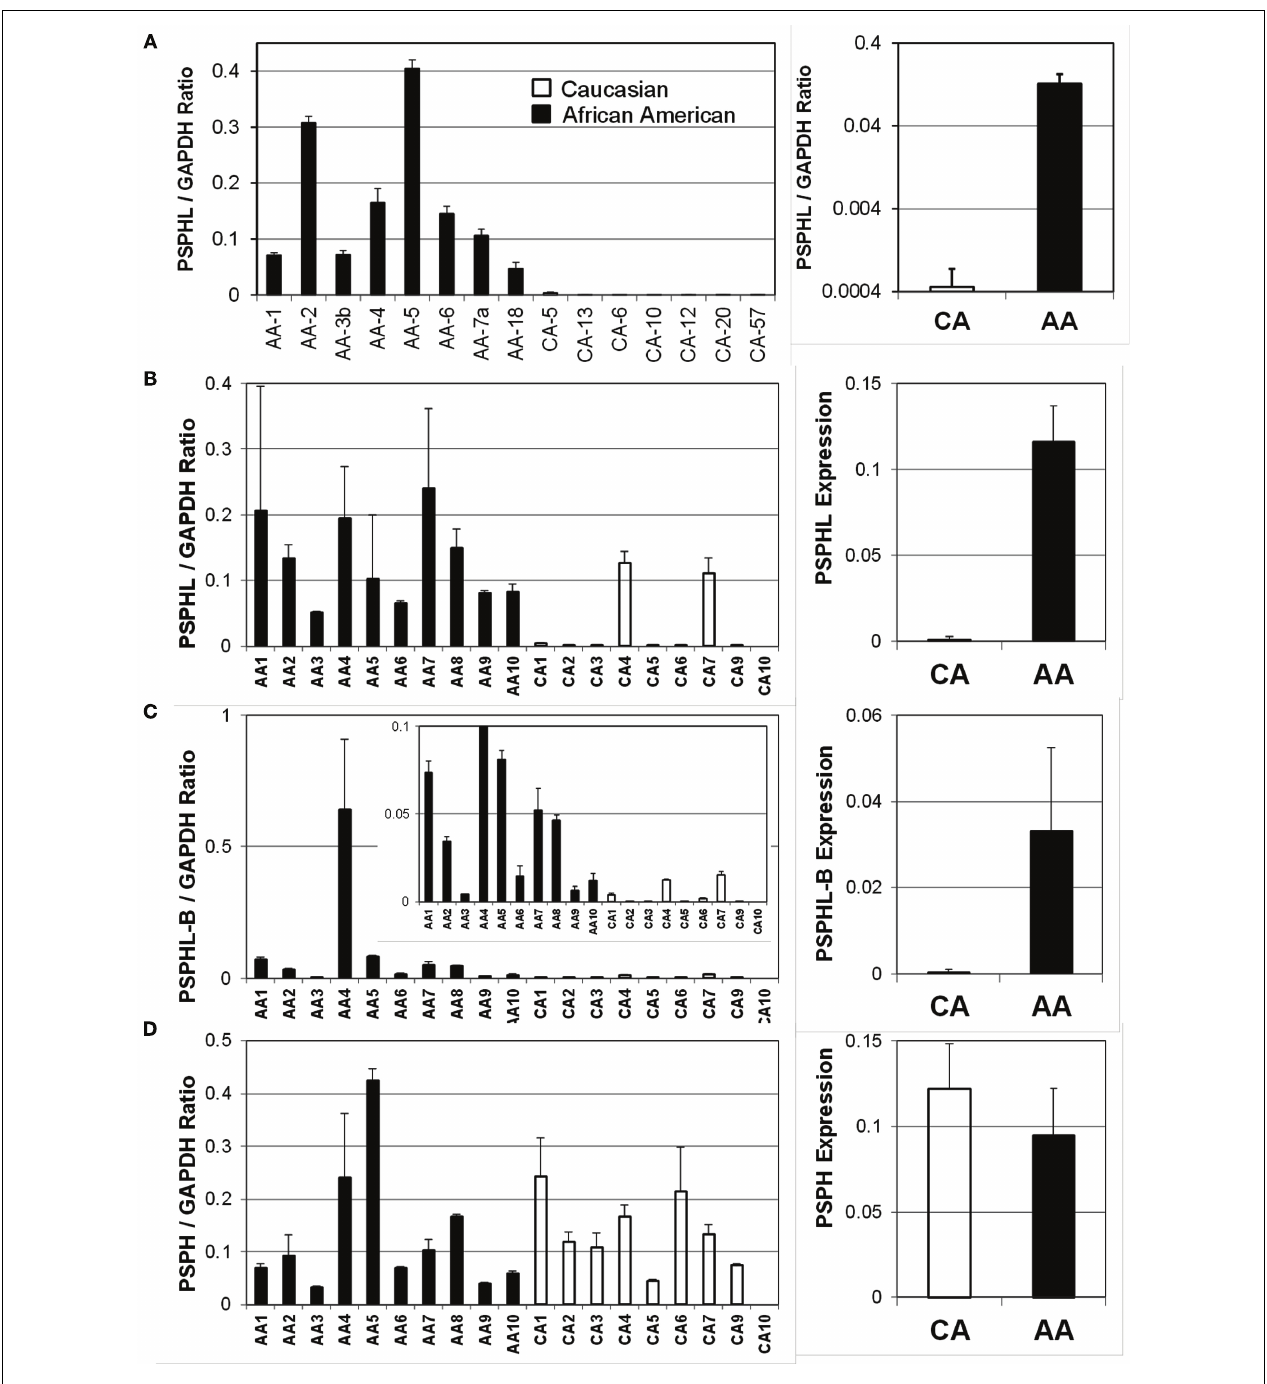
Right: geometric averages. Error bars indicate standard error.The inset of (C) shows ratios in expanded scale. AA/CA ratios: A =233. B =139. C =92, D =0.78; p -values A =1.24×10 − 7 ; B =0.00075; C =0.001; D =0.46.